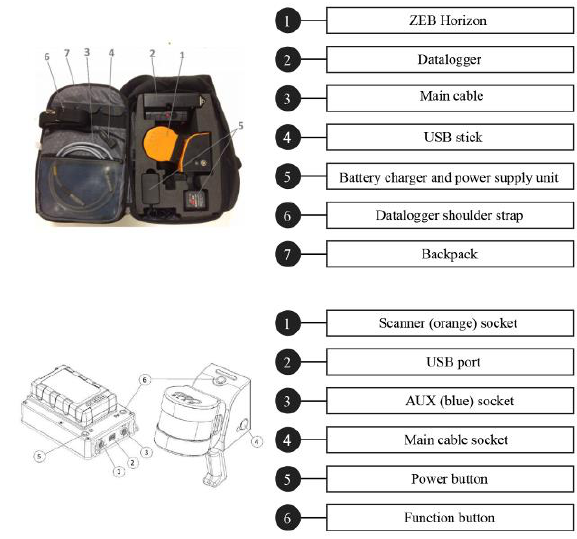
Figure 4 . Main components of the wearable mobile laser systems (WMLS) used for data acquisition.